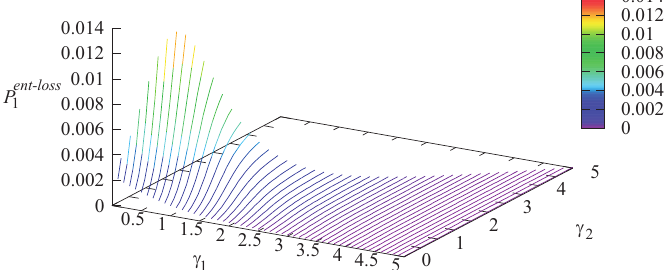
Figure 2. Dependence of the probability P ent − loss to Storage 1 overflow on γ 1 and γ 2 .